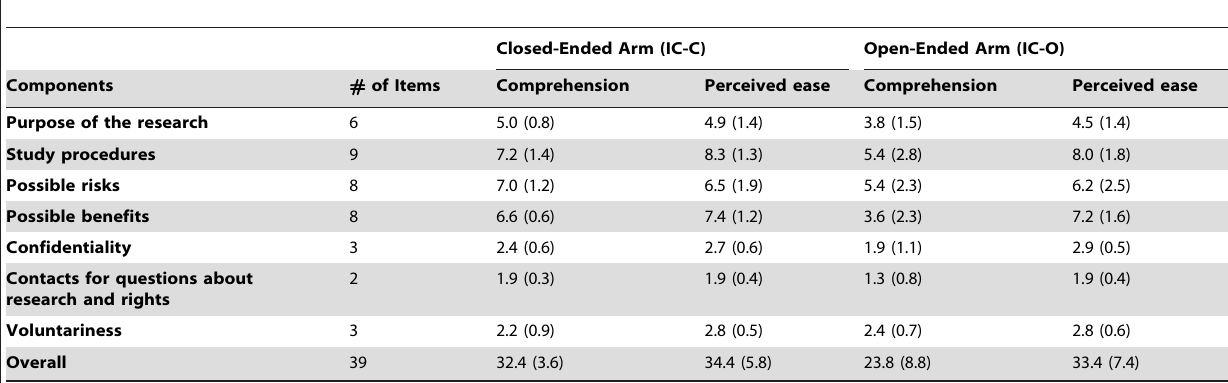
Table 3. Comprehension scores and perceived ease of understanding of informed consent content, overall and by components, by randomization arm (mean, standard